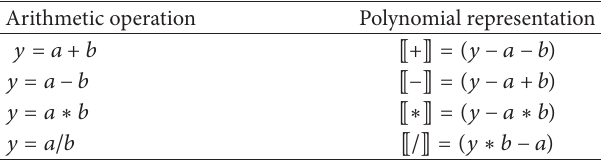
Table 1: Polynomial model for arithmetic operation.